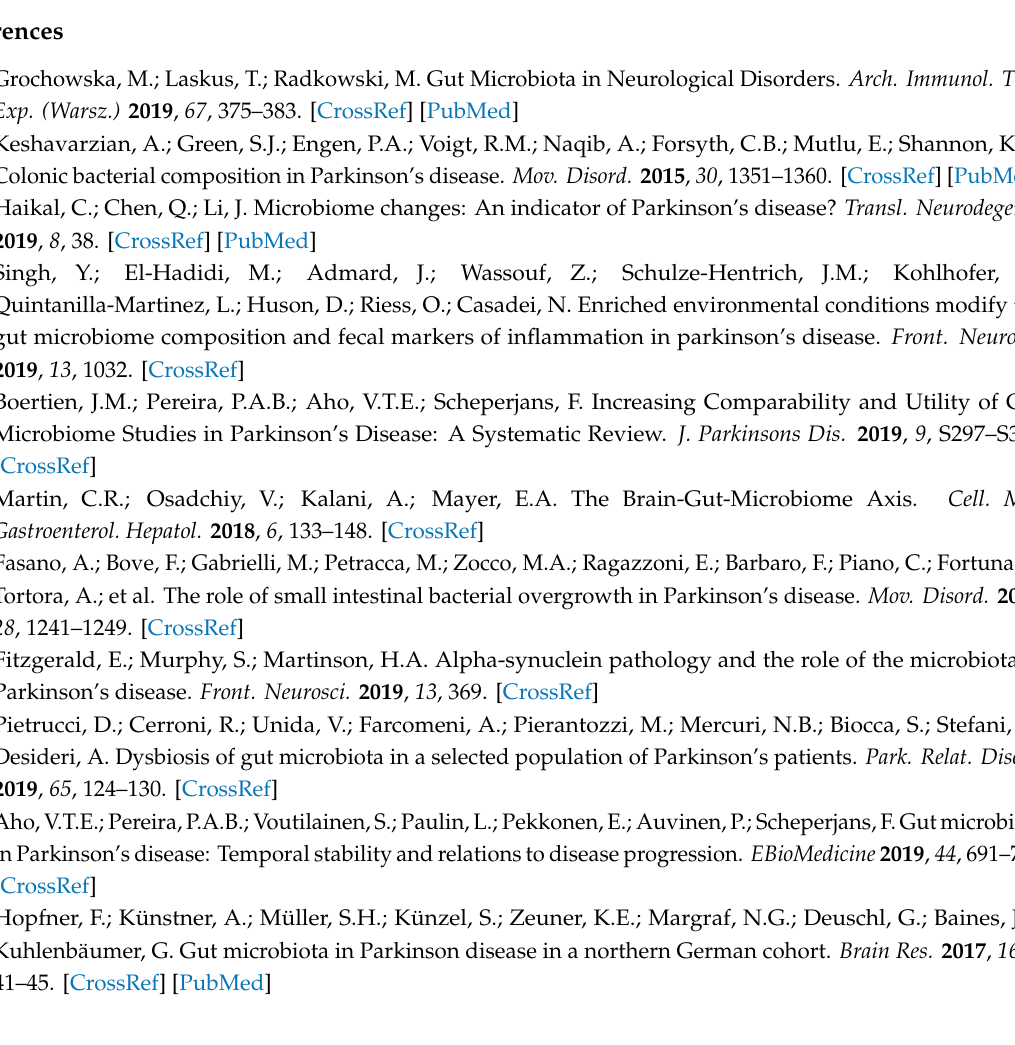
Table S1: Random forest performance with a reduced number of bacterial families. Author Contributions: Conception and design of the study, D.P. and A.D.; Acquisition of data, V.U. and R.C.; Bioinformatic and machine learning data analysis, D.P. and A.T.; Analysis and interpretation of data, D.P., A.T., and A.D.; Writing the article, D.P. and A.T.; Revising the article, D.P., A.T., V.U., R.C., S.B., A.S. and A.D.; All authors have read and agreed to the published version of the